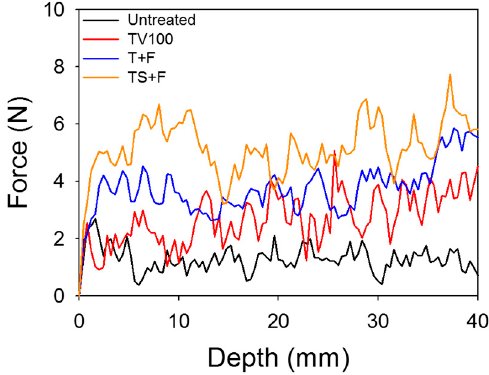
Figure 6. Drilling resistance versus testing depth of treated stone samples and their untreated counterpart.